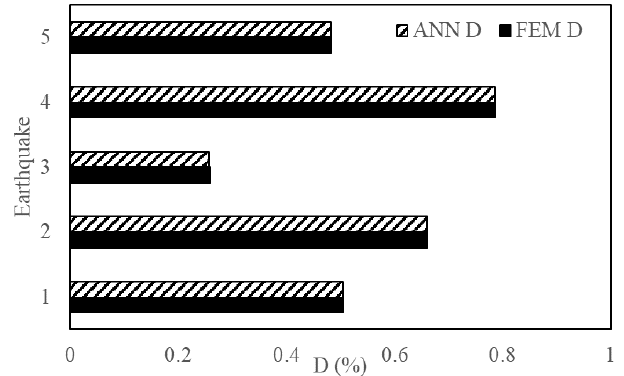
obtained from other conventional methods. Table 4 lists the characteristics of these EQs. Figure 14. Acceleration of a four-story structure obtained from ANN and NLTHA for five EQs. Figure 16 shows the design spectrum of these EQs. Table 4. Characteristics of design-based and maximum considered test EQs for a three-story mass irregular structure.